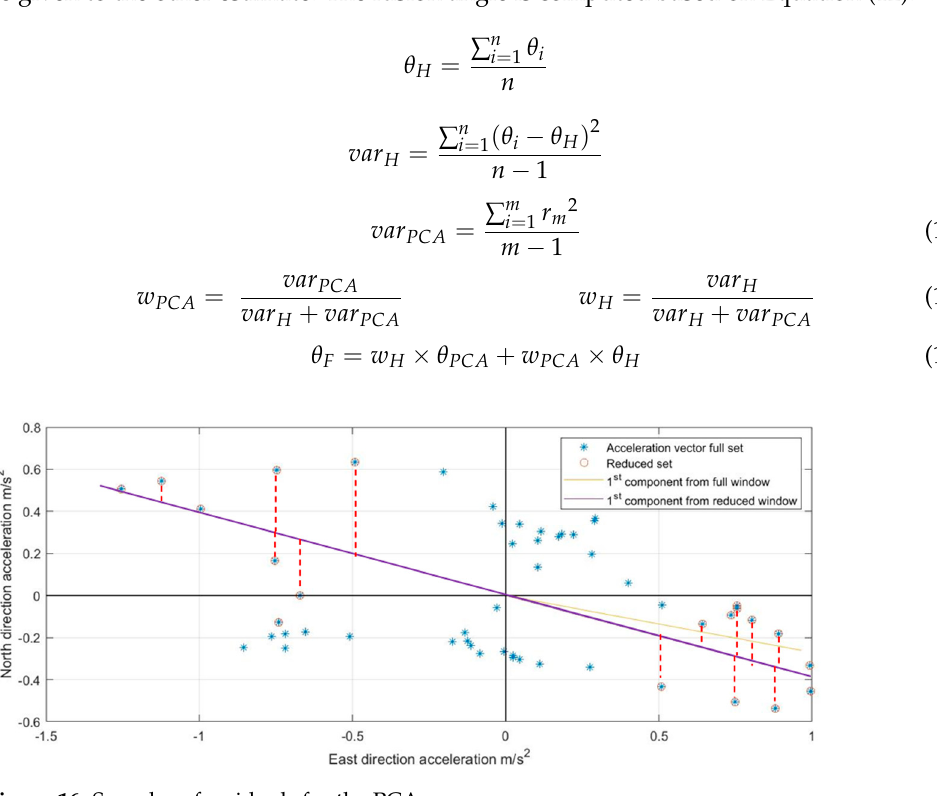
Figure 16. Samples of residuals for the PCA.